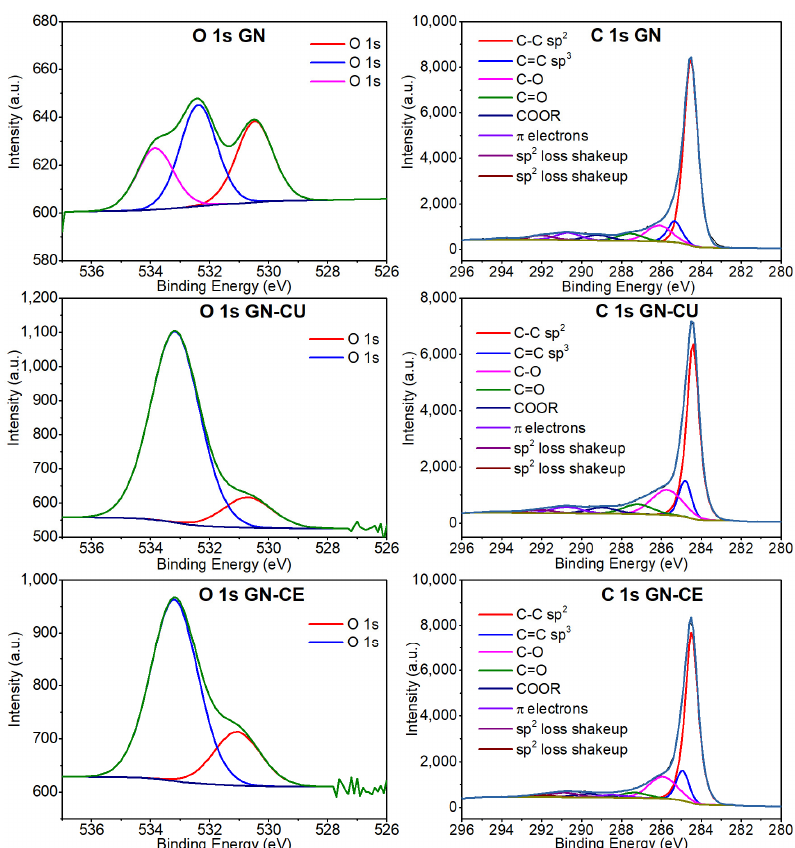
Figure 3. Peaks deconvolution of O1s and C1s of the GN, GN–CU and GN–CE.